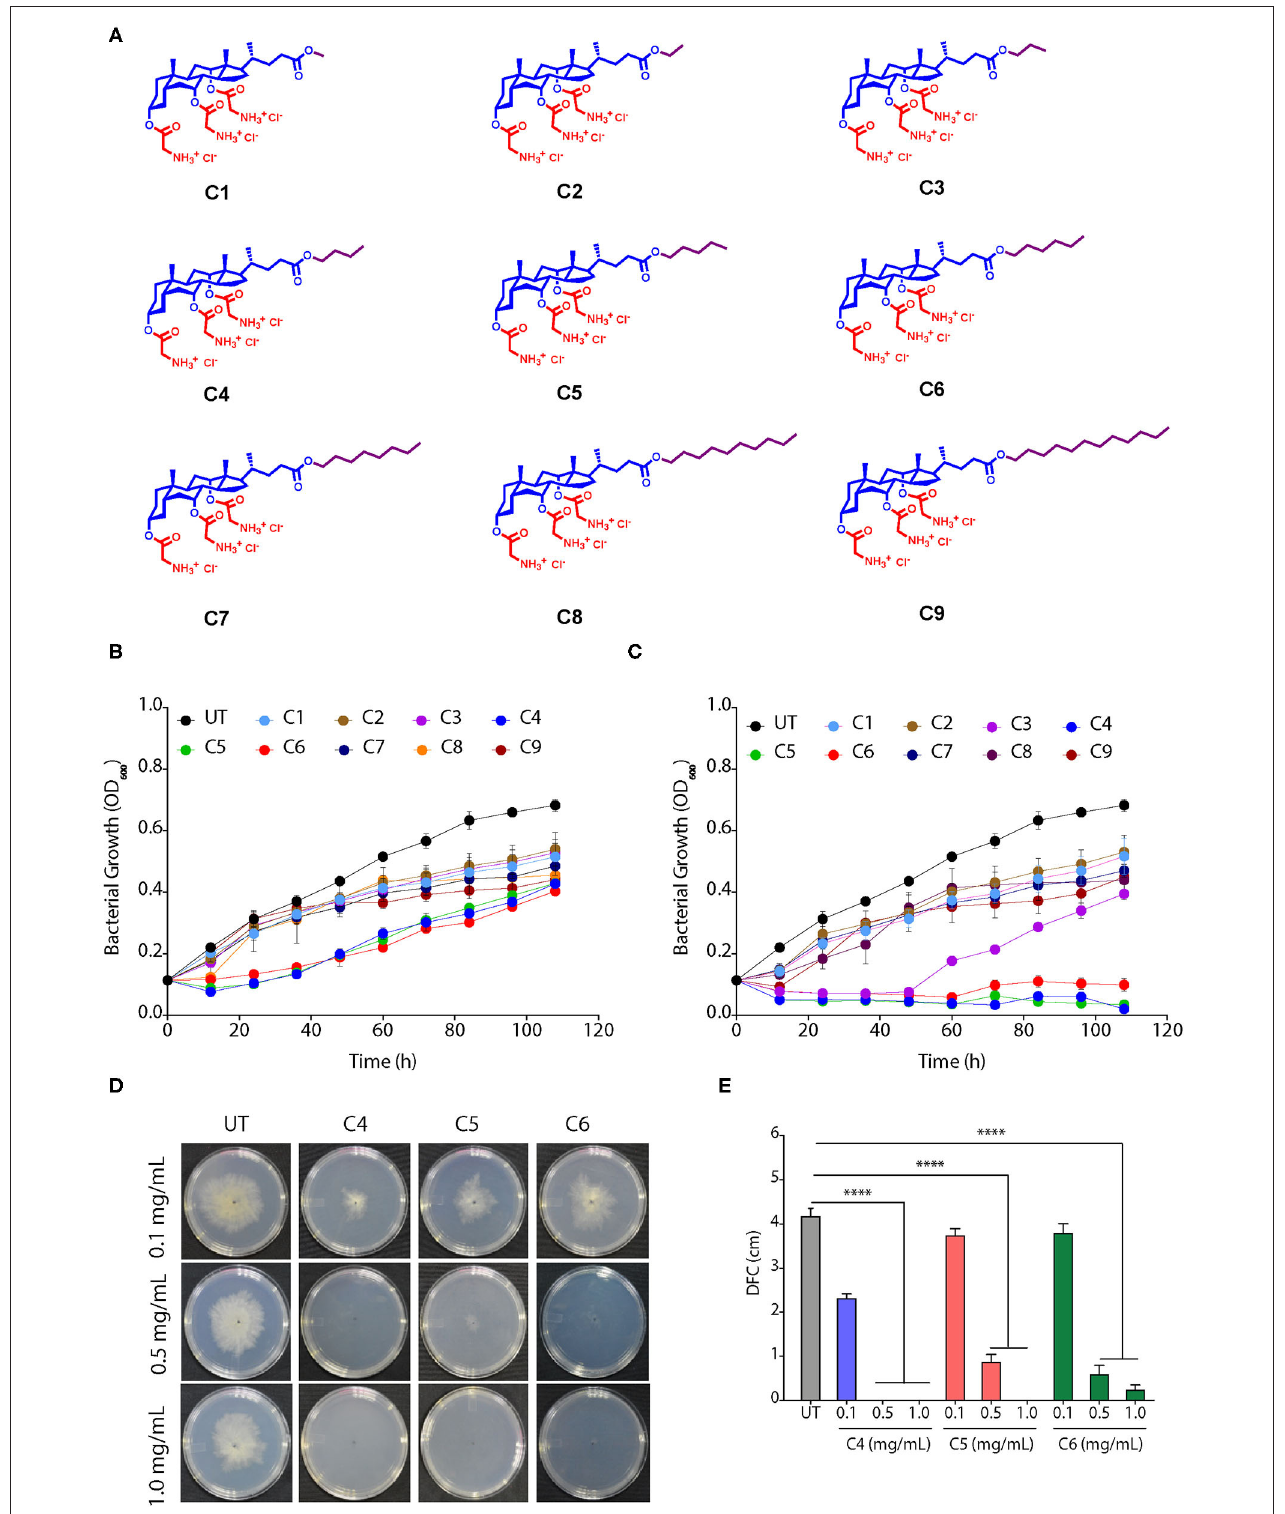
FIGURE 1 | Cholic acid-glycine conjugates (CAGCs) are broad spectrum antimicrobials. (A) Molecular structures of CAGCs tested in this study. (B, C) Change in growth kinetics of Xanthomonas Oryzae pv. oryzae ( Xoo) in presence of (B) 8, and (C) 16 µ g/ml of CAGCs. UT-untreated bacterial culture. The 10 6 CFU/ml Xoo culture was incubated with the CAGCs for different time points and plated on nutrient broth (NB) medium and colony forming units (CFU) were measured. (D) Change in